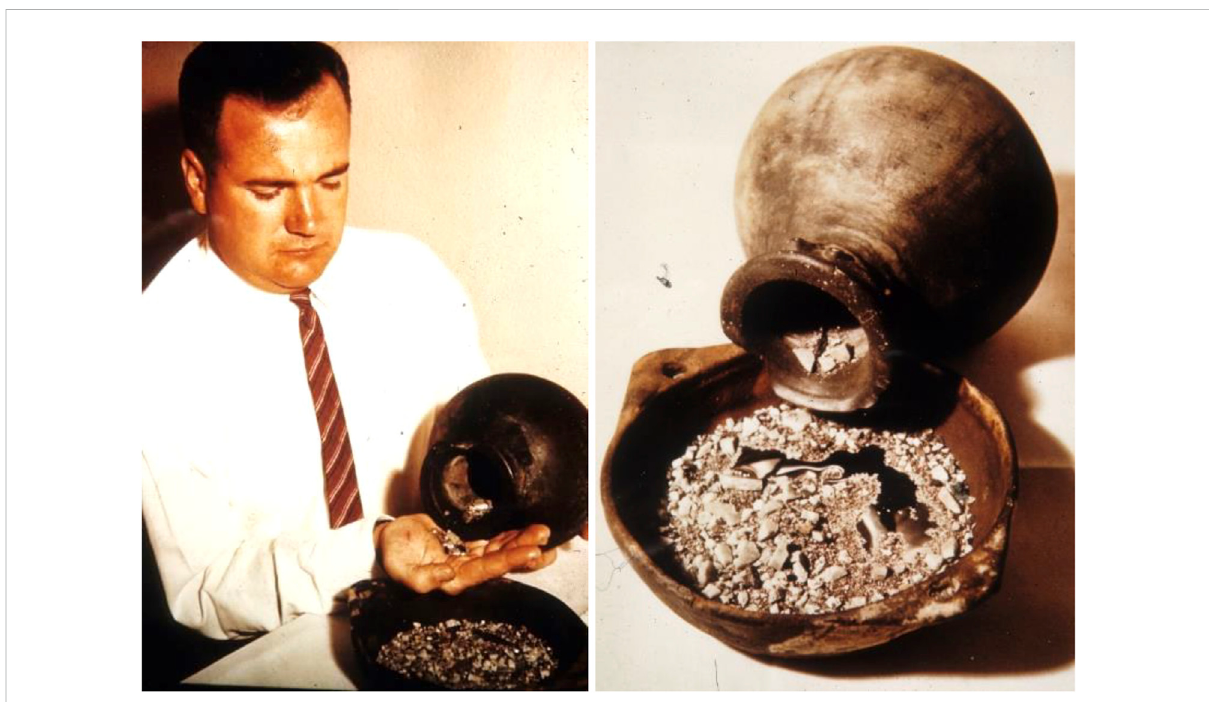
FIGURE 2 GeologistJimKitchen(left)holdingthevesselheretrievedfromthesubmergedsiteLavaderosinLakeAmatitlán,Guatemala,and(right)acloser viewofthecontents ofthevessel,showingstonedebitage(?)suspendedon elemental mercury. Estimatesofthesizeofthebowlanddepth ofliquid suggest that there may have been 500 cm 3 or more of elemental mercury inside, which accounts for the notable weight of the vessel reported by Kitchen (Deuel, 1974). Scanned version of original slides archived in the Milwaukee Public Museum. Used with